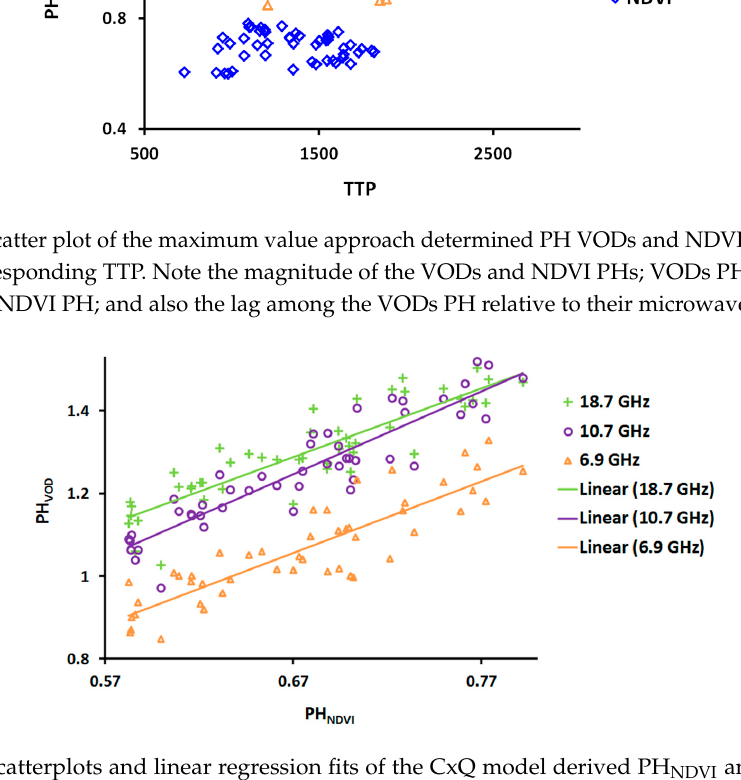
Figure 11. Scatterplots and linear regression fits of the CxQ model derived PH NDVI and maximum value determined PH VOD at three microwave frequencies (6.925 GHz (orange triangles), 10.65 GHz (purple circles), and 18.7 GHz (green plus)) for 2003–2010. The PH linear fits for two datasets were high with coefficients of determination of 0.77, 0.84, and 0.78 for the 6.925, 10.65, and 18.7 GHz frequencies, respectively.